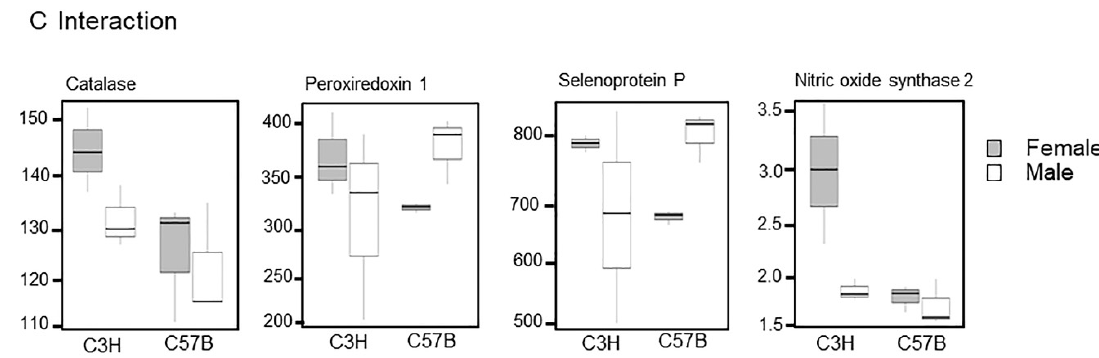
Figure 4. Transcripts within the inflammation, oxidant, and antioxidant pathways. Selected tran- scripts which differed between ( A ) strain, ( B ) sex, and ( C ) interaction were plotted.